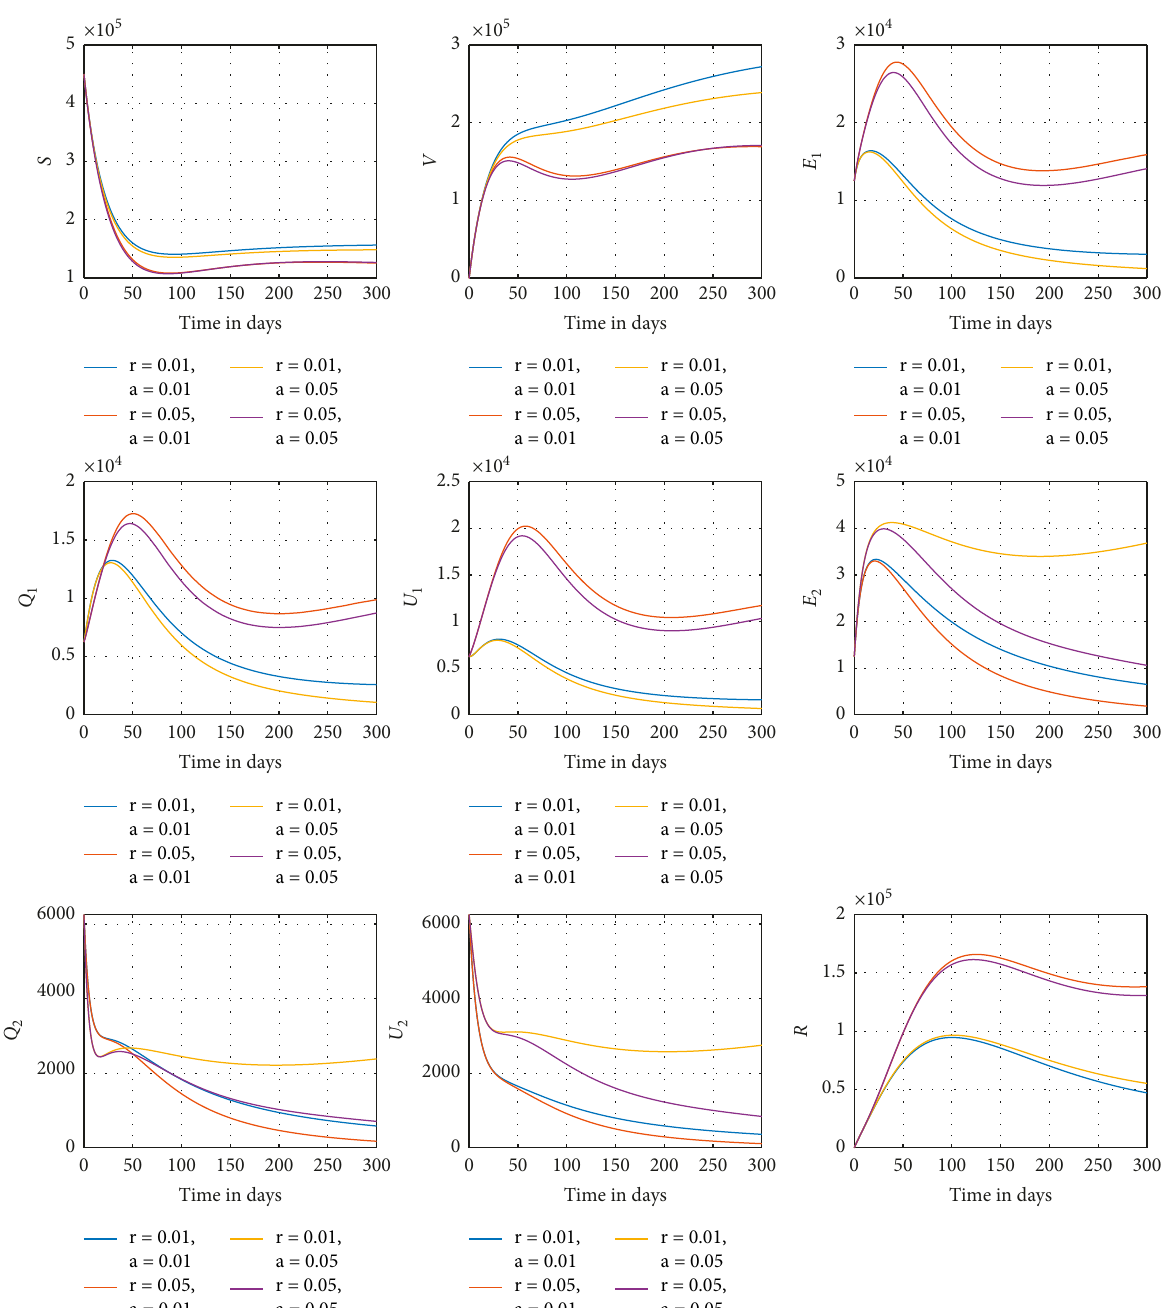
Figure 6: Investigation of the impact of escape of quarantined infectious individuals from isolation centers, where S is the susceptible is the individuals exposed to variant 1, Q is the quarantined individuals who are infected individuals, V is the vaccinated individuals, E 1 1 with variant 1, U is the undetected individuals who are infected with variant 1, E is the individuals exposed to variant 2, Q 1 2 is the undetected individuals who are infected with variant 2, and R is the quarantined individuals who are infected with variant 2, U 1 recovered